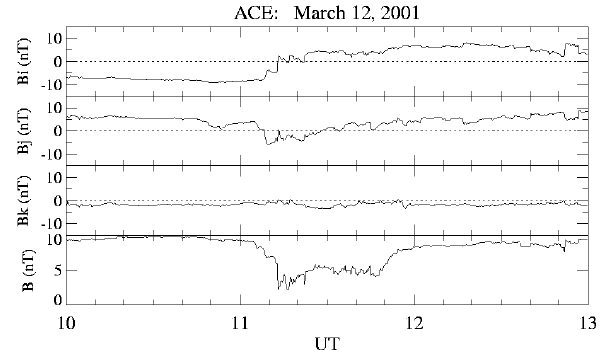
Fig. 4. ACE magnetic field data between 10:00 and 13:00UT in minimum variance coordinates, where i is the direction of maxi- mum variance and k is the direction of minimum